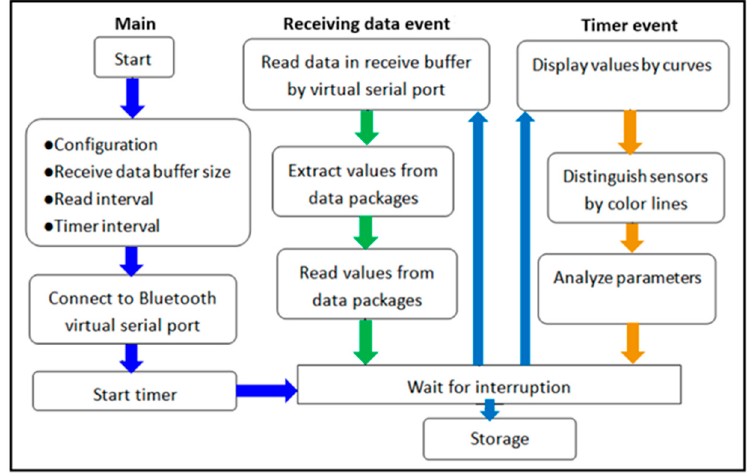
Figure 9. A flowchart of the developed data processing system in the pressure monitoring and display software.